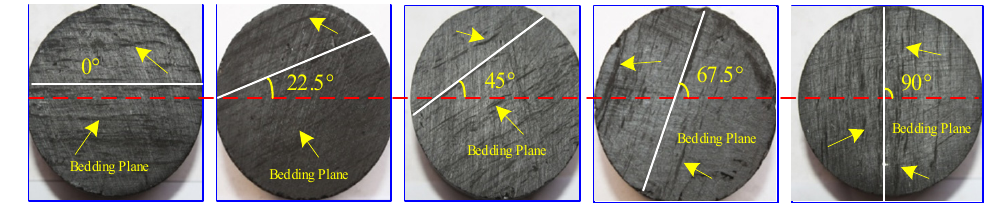
Figure 2. Actual photos of prepared coal specimens.